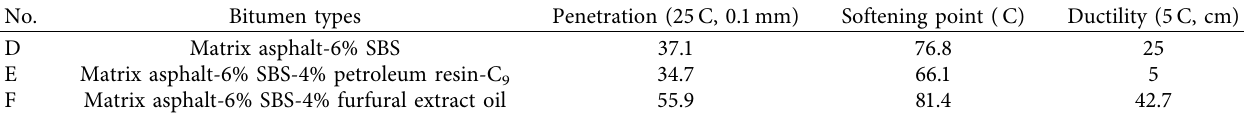
Table 8: Experimental results of SBS-modified asphalt under different